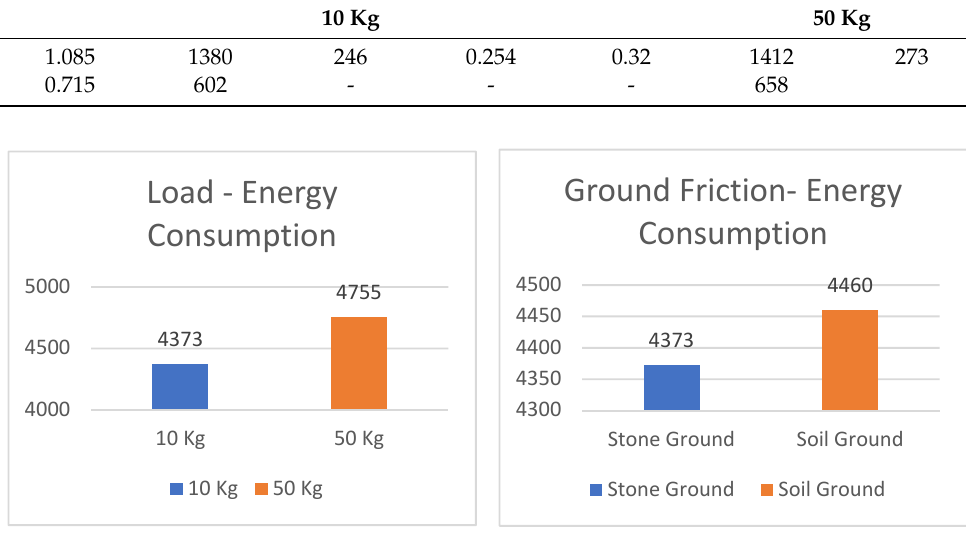
Table 6. Effect of load change.